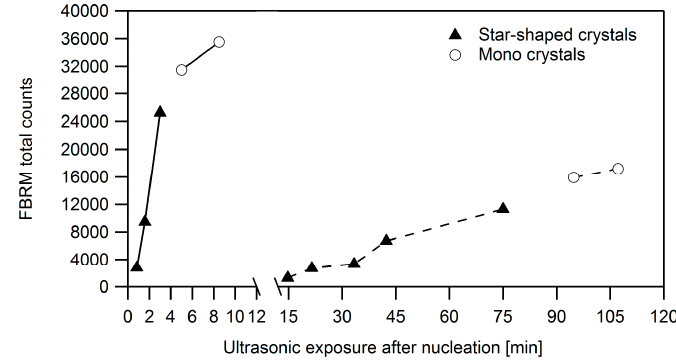
Figure 15. Measured total FBRM counts at the moment that sonication is disabled as a function of the ultrasonic exposure time after the detection of nucleation, performed at two seeding temperatures. Solid lines represent the data obtained at 57 °C ( C 0 / C sat = 5.28), while the dashed lines indicate results at 70 °C ( C 0 / C sat = 1.77). The final morphology after completion of the crystallization protocol is indicated.